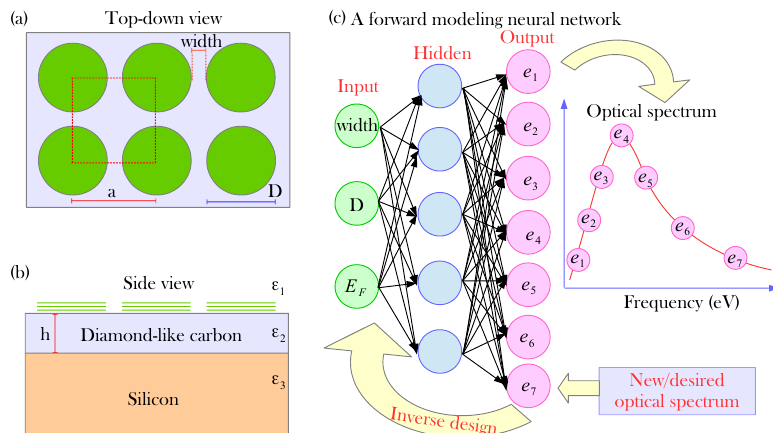
Figure 1. (Color online) ( a ) the top-down view and ( b ) the side view of graphene based systems including structural parameters; ( c ) the neural network architecture has three main components: inputs (width, D , E F ), hidden layers, and outputs (the optical spectrum). E F is a chemical potential of graphene. There are three hidden layers in our actual neural